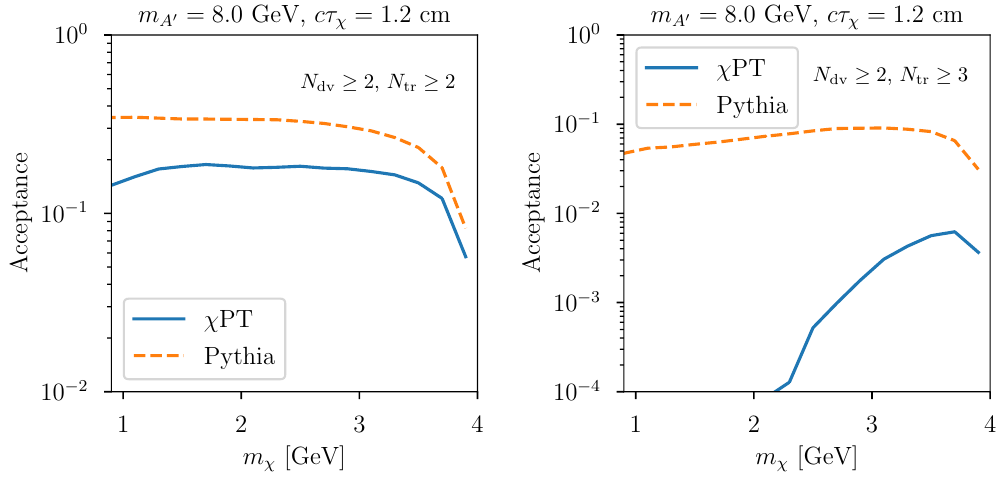
Figure 17 . Comparison of LLP signal acceptances evaluated in two different hadronization models of χ → ¯ uu ¯ uu for m = 8 GeV and cτ 1 cm . In the left (right) panel we show the N A 0 χ ≈ N tr ≥ 2 ( N dv ≥ 2 , N tr ≥ 3 ) analyses. The solid blue lines show acceptances for final state generated using chiral perturbation theory/hidden local symmetry approach, while the orange dashed lines were obtained using Pythia